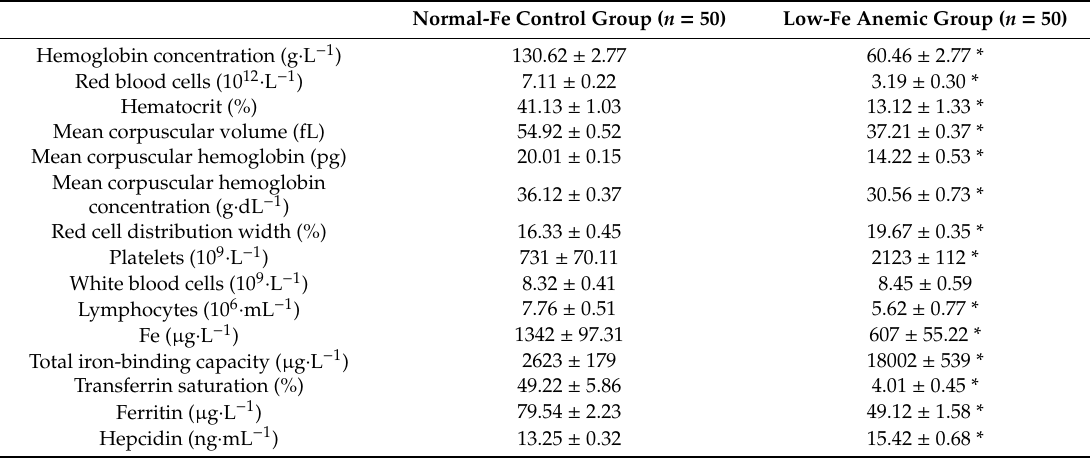
Table 1. Hematological parameters from control and anemic rats (pre-experimental period). Normal-Fe Control Group ( n =